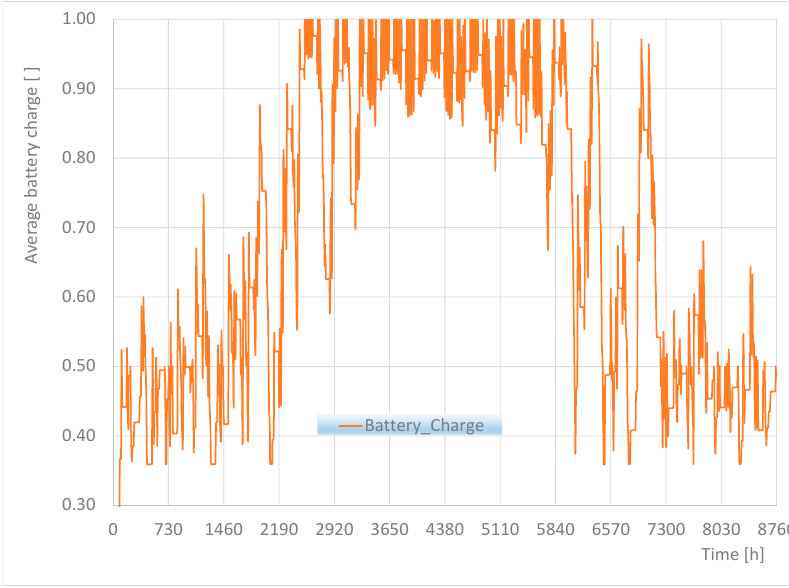
Figure 5. Evolution of battery charge during one full year (20 kW Genset).